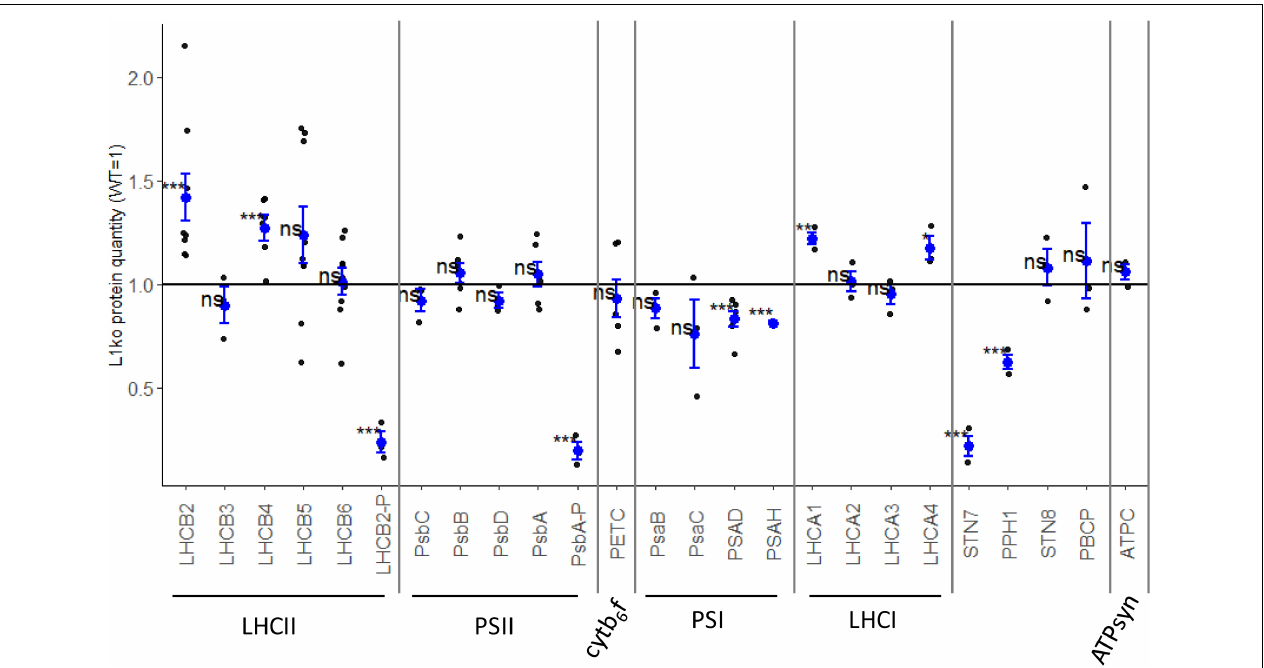
FIGURE 2 | Few thylakoid proteins are affected by the loss of LHCB1. The accumulation of proteins was assessed in 14-days-old seedlings of WT and L1ko lines by immunoblotting. The relative protein accumulation, normalized over the actin, was measured compared to the WT level. Each point represents the quantification of the relevant protein in an individual biological replicate; we analyzed one sample per genotype for proteins with low variation between lines and two or three samples for proteins with larger variation. The blue dot represents the average and the blue bars the standard error of the distribution. The proteins were divided into the complexes to which they are associated (LHCII, PSII, cytb6f, PSI, LHCI, and ATPsyn). The accumulation kinases and phosphatase mainly involved in the regulation of the phosphorylation of LHCII and PSII were also measured. The measured levels were compared to the average of 1, corresponding to the protein accumulation in WT extracts via a Student’s t -test; asterisks indicate p -value thresholds (0.0001 < p < 0.001 “***”, 0.001 < p < 0.05 “**”, 0.05 < p < 0.10 “*”, 0.10 < p “ns”) (see Supplementary Figures 3A,B